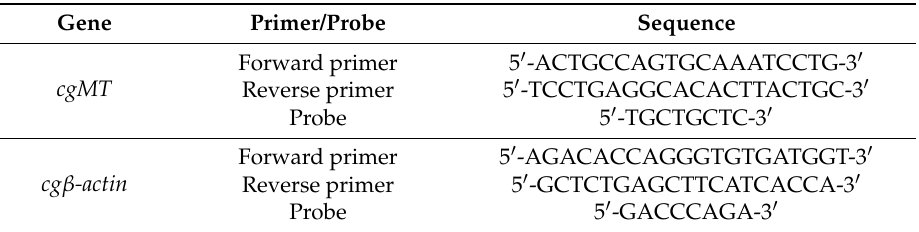
The reaction mixture contained the following: 2 µ L cDNA (1:10), 0.8 µ L of 10 µ M forward